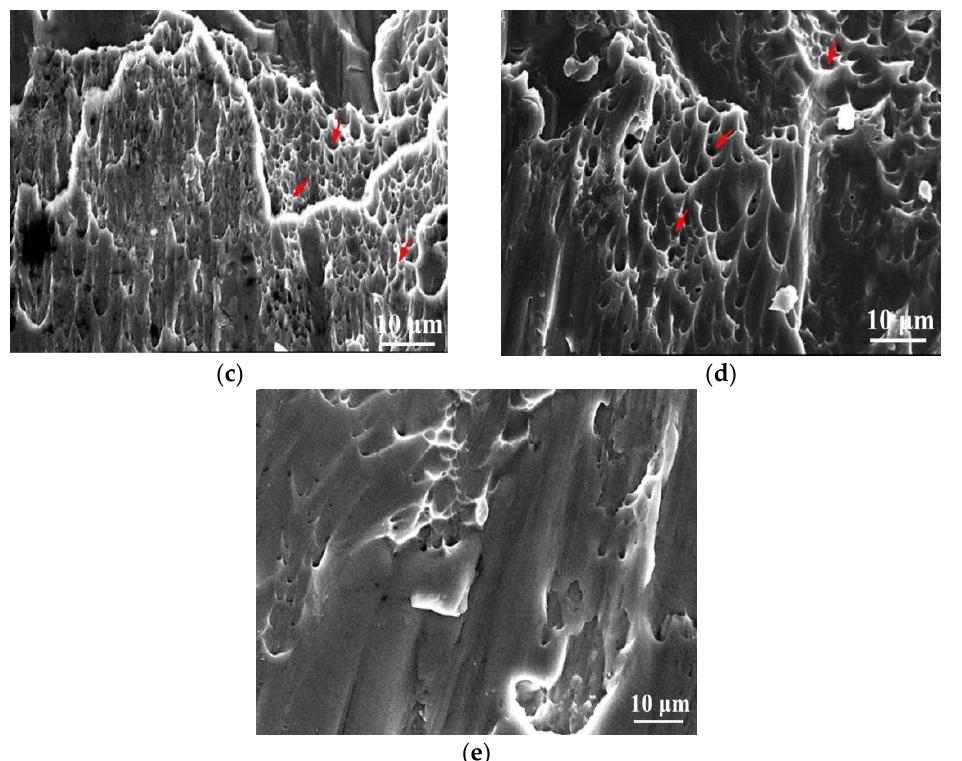
Figure 5. Fracture morphology of samples sintered at different temperatures: ( a ) 1223 K, ( b ) 1323 K, ( c ) 1423 K, ( d ) 1523 K, and ( e ) 1623 K.